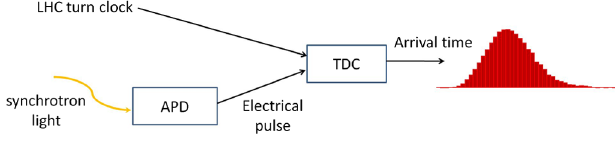
FIG. 1. Schematic of the longitudinal density monitor.